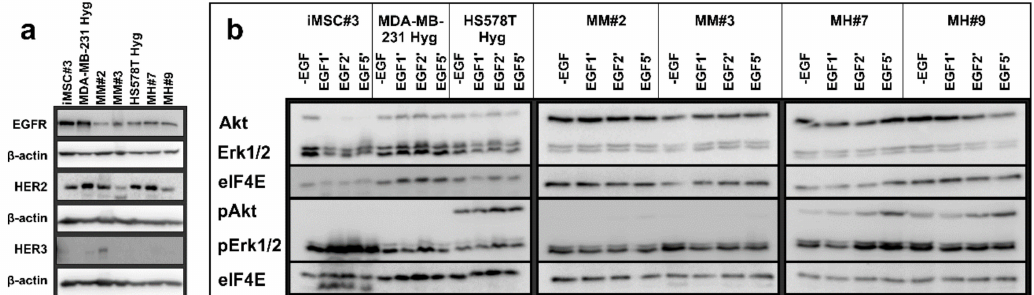
Figure 6. Representative images of Western blot studies. ( a ) Shown are the expression patterns of epidermal growth factor receptor (EGFR), human epidermal growth factor receptor 2 (HER2) and HER3 for all seven cell lines. ( b ) Cells were treated with EGF for 1, 2 or 5 min. Afterward, the expression of Akt, pAkt, Erk1 / 2 and pErk1 / 2 was determined by Western blot analysis.